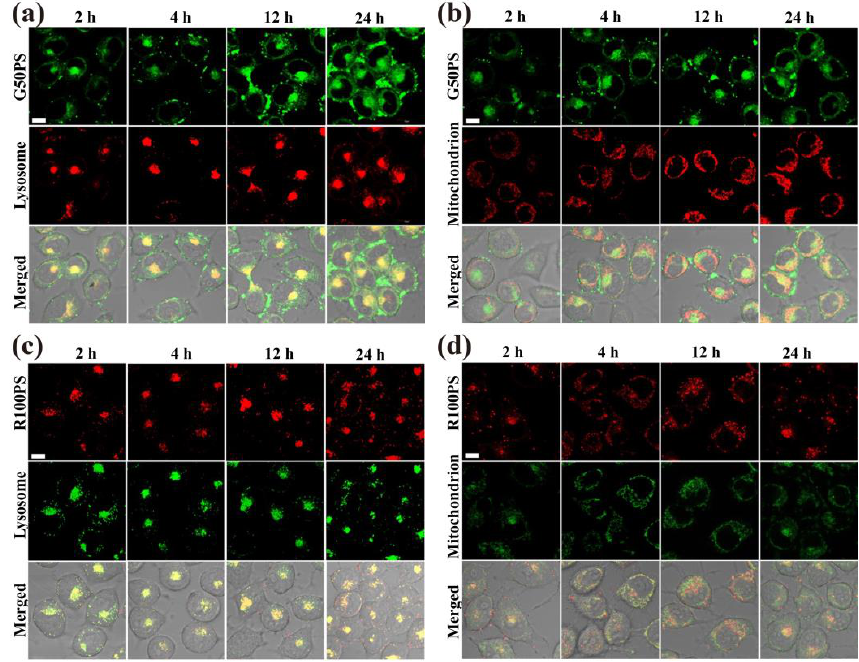
Figure 5. CLSM images of the subcellular location of PS NPs (20 μg/mL) in A549 cells after exposure to G50PS (green color) or R100PS (red color) for different times. Lysosomes and mitochondria are labeled red ( a-b ) or green ( c-d ). The scales represent 10 μm.